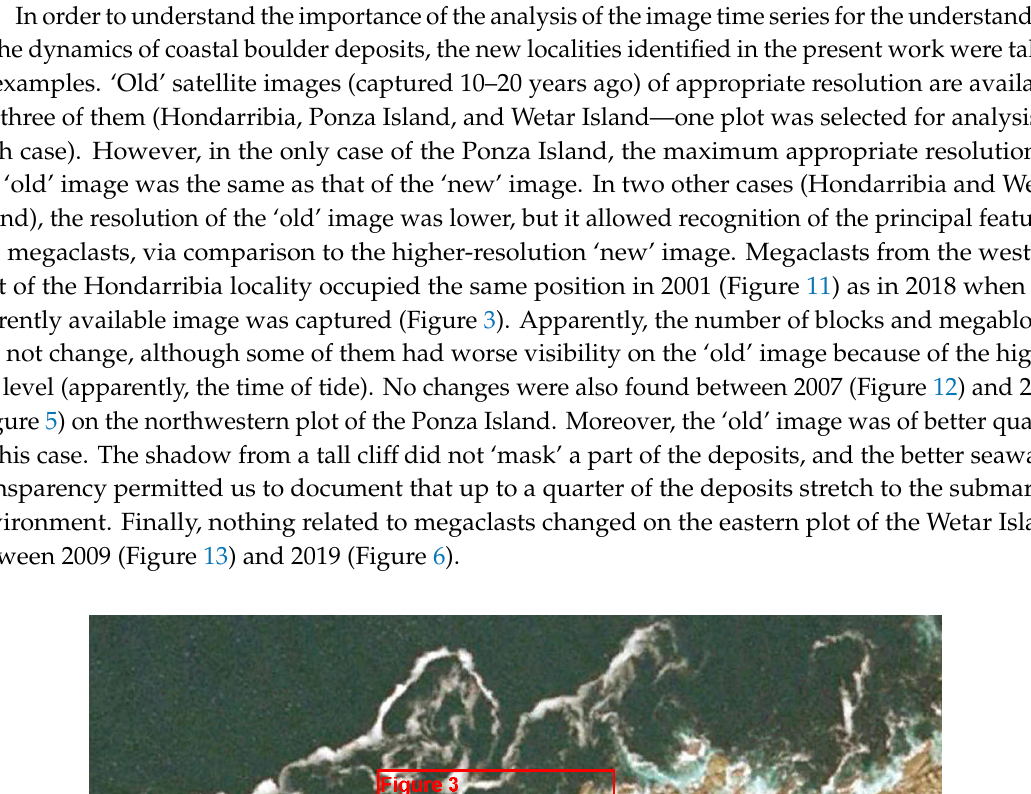
Figure 12. Satellite view of the northwestern plot of the Ponza Island locality in 2009 (the view provided by the Google Earth Engine).